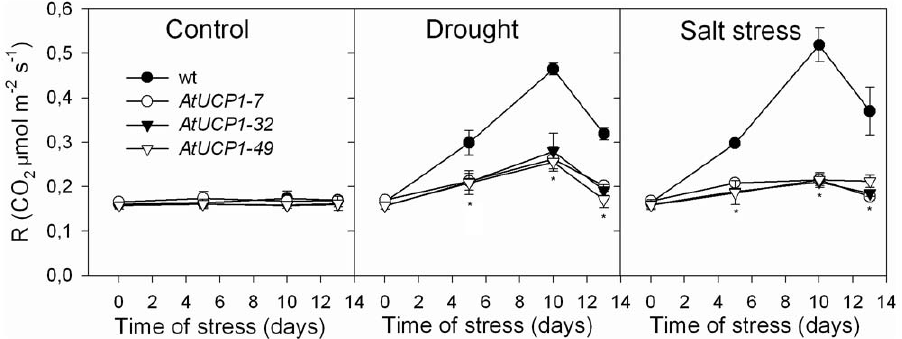
Figure 5. Respiration in the leaves of wild-type (WT) and AtUCP1 transgenic tobacco plants. Thirty-day-old plants were exposed for 10 days to 200 mM mannitol or 175 mM NaCl and then recovered with pure water for 3 days. Values represent the mean of three replicate measurements. * indicates significant differences relative to the control at P , 0.0001.